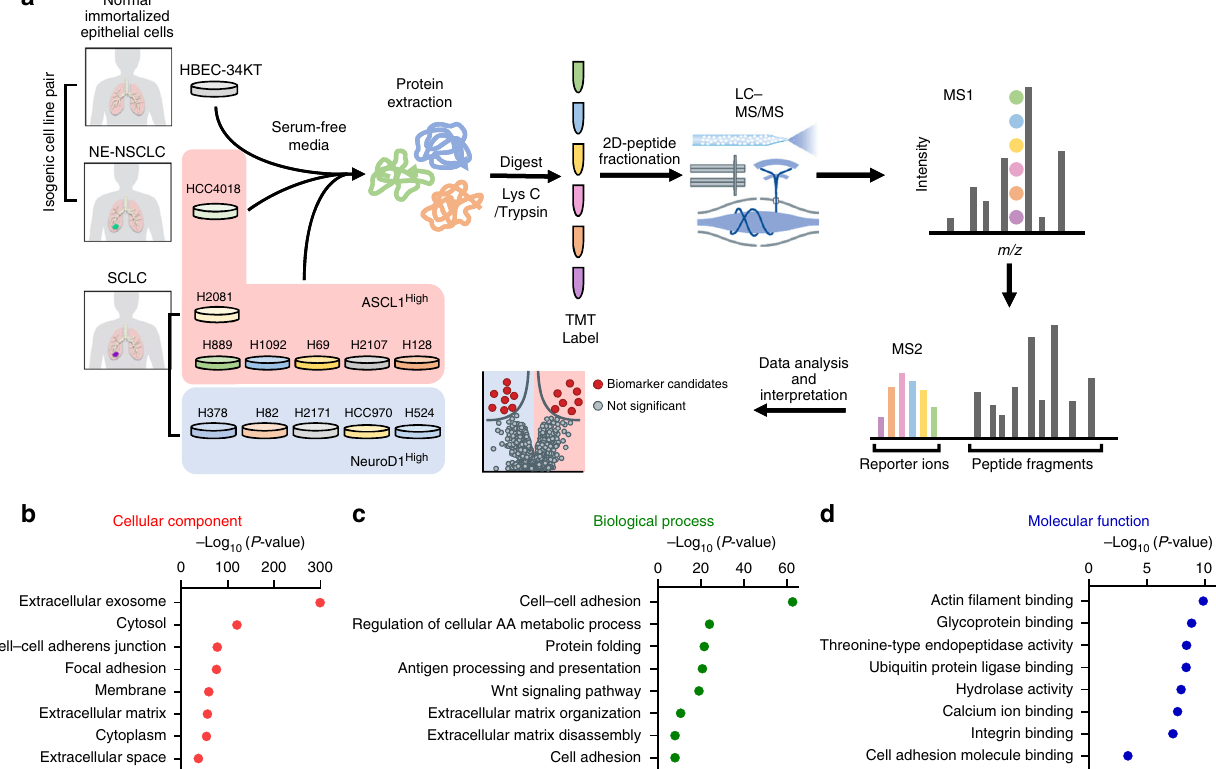
Fig. 1 Quantitative mass spectrometric analysis of the neuroendocrine (NE)-lung cancer secretome. a Schematic overview of the quantitative proteomic platform. Brie fl y, proteins from the conditioned media (CM) were extracted and then digested with trypsin. The samples were labeled with the tandem mass tag (TMT) reagents. b – d Gene Ontology (GO) analysis of the proteins identi fi ed from the CM samples of the thirteen lung cell lines shown in a . Cellular component ( b ), biological processes ( c ), and molecular function ( d ) analyses were